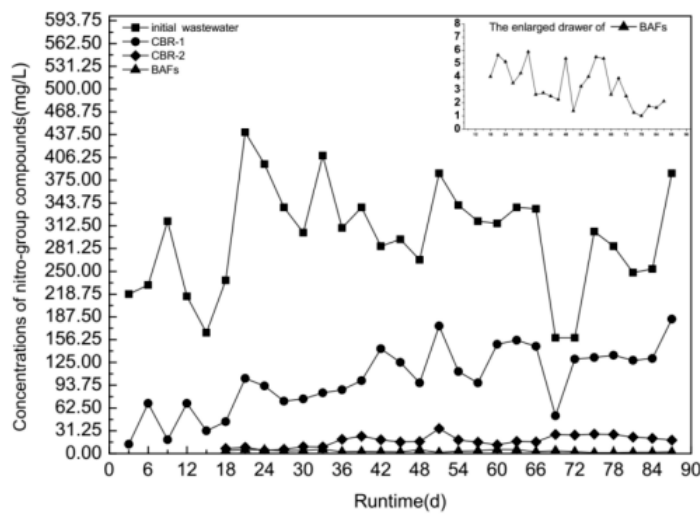
Figure 11. The concentration of nitrobenzene compounds in effluent of stage 1. Catalysts 2018 , 8 , x FOR PEER REVIEW